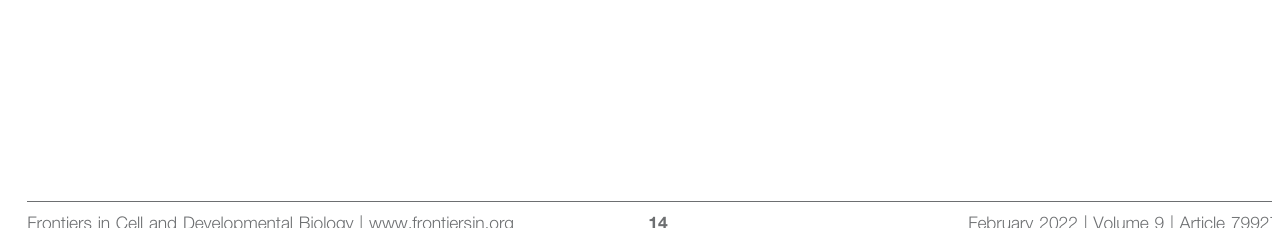
Frontiers in Cell and Developmental Biology |